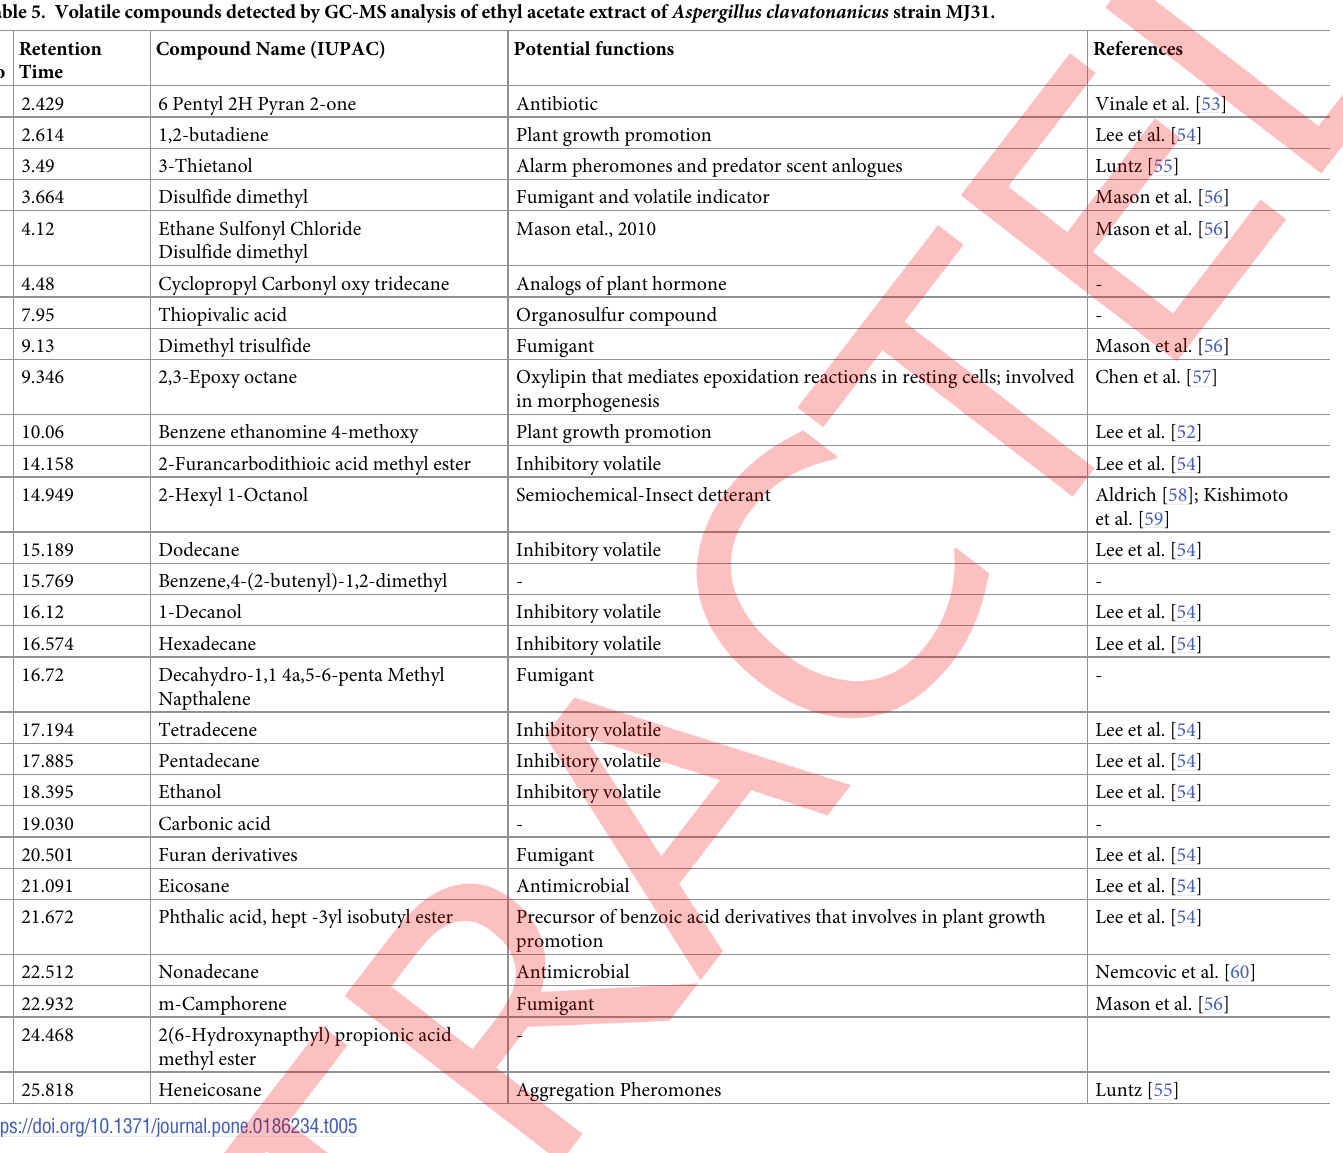
Table 5. Volatile compounds detected by GC-MS analysis of ethyl acetate extract of Aspergillus clavatonanicus strain MJ31. Sl. Retention No Time